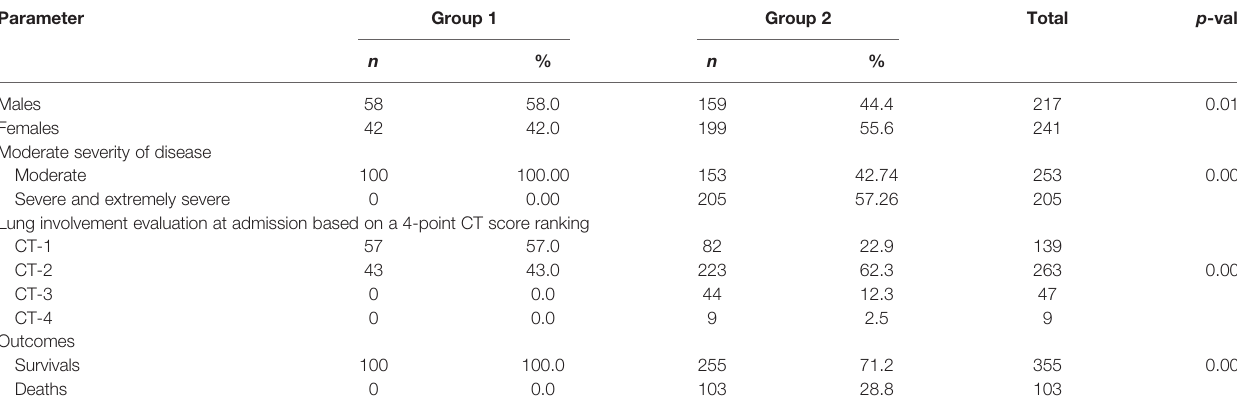
TABLE 2 | Disease severity in different groups of patients.